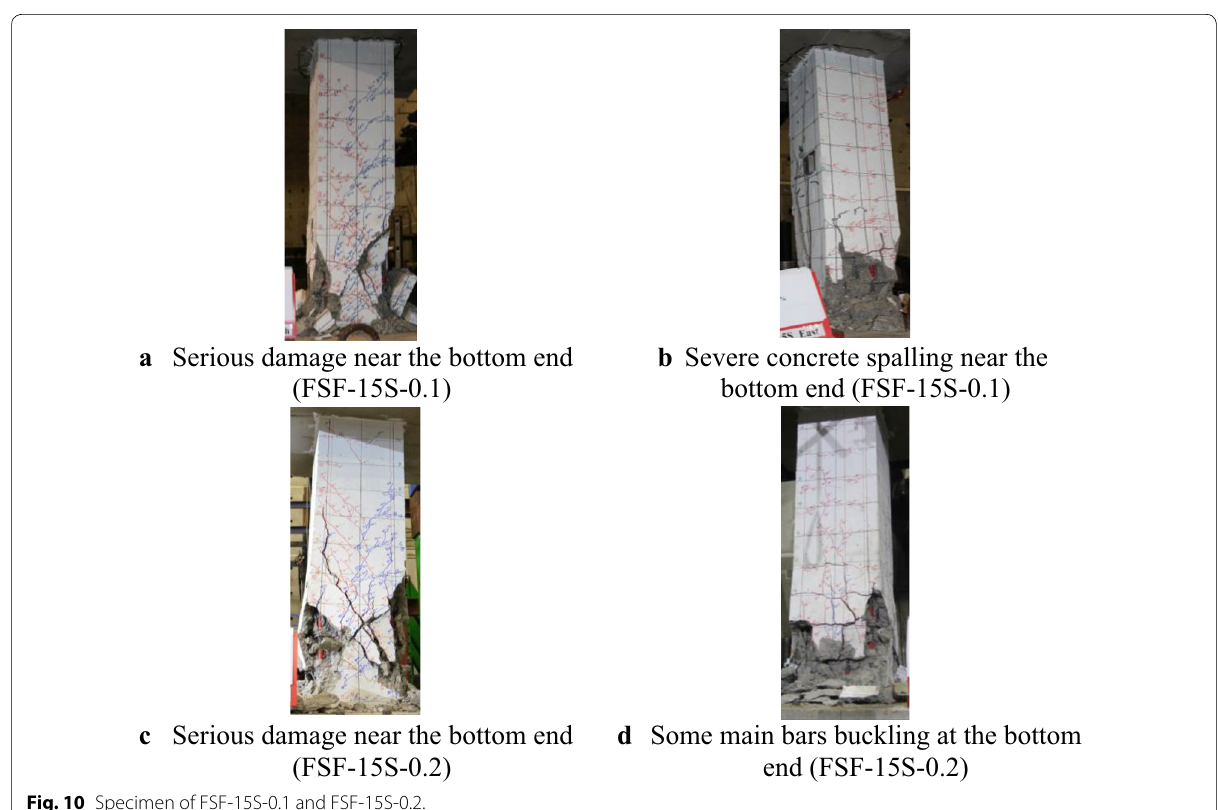
Fig. 10 Specimen of FSF‑15S‑0.1 and